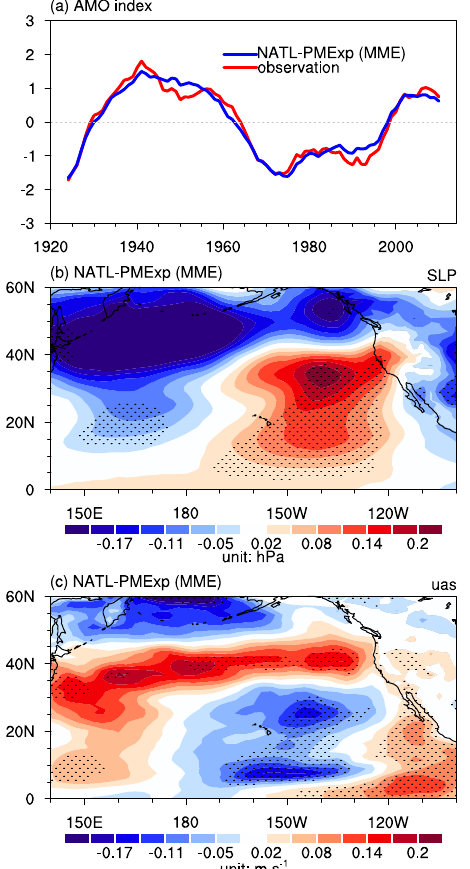
Fig. 7 Modulations of the AMO on the Paci fi c mean states in the pacemaker experiments. a Annual mean AMO index with 9-year running average derived from the observation and ensemble mean of the NATL-PMExp (see “ Pacemaker experiments ” in “ Methods ” ). Differences of the background mean b SLP and c surface zonal wind in JFMAM(0) between positive and negative AMO phases in NATL- PMExp. Stippling regions in b , c indicate the differences that are signi fi cantly different from zero at the 95% con fi dence